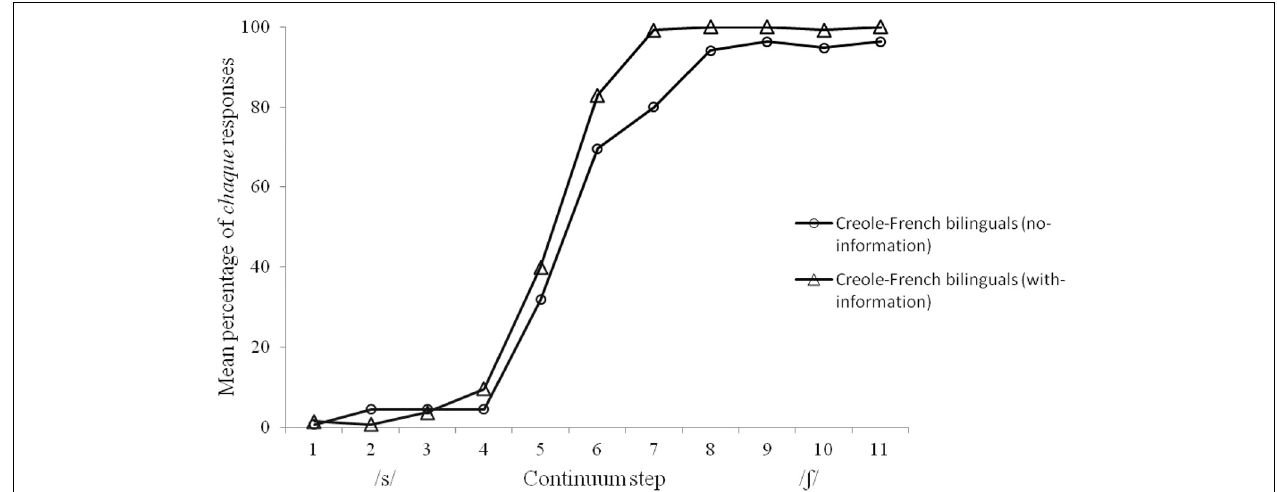
FIGURE 4 | Individual categorization scores (in %) for the two groups of Creole-French bilinguals (no- and with- information).